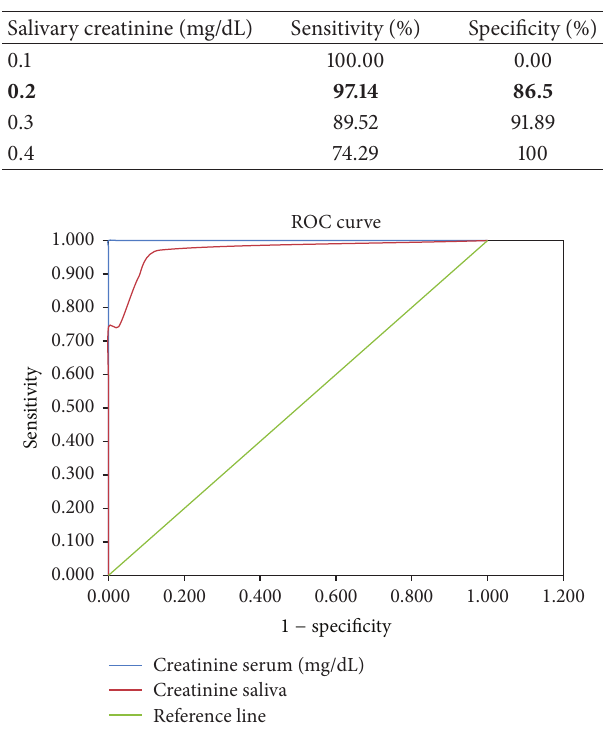
Table 5: Sensitivity and specificity analysis of salivary creatinine for different cut-off values considering serum creatinine as the gold standard.